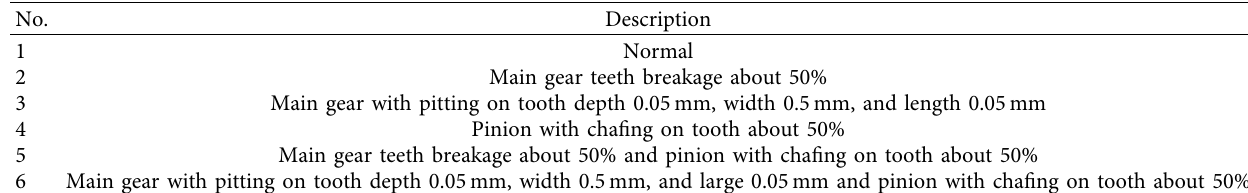
Table 2: The description of each fault condition.